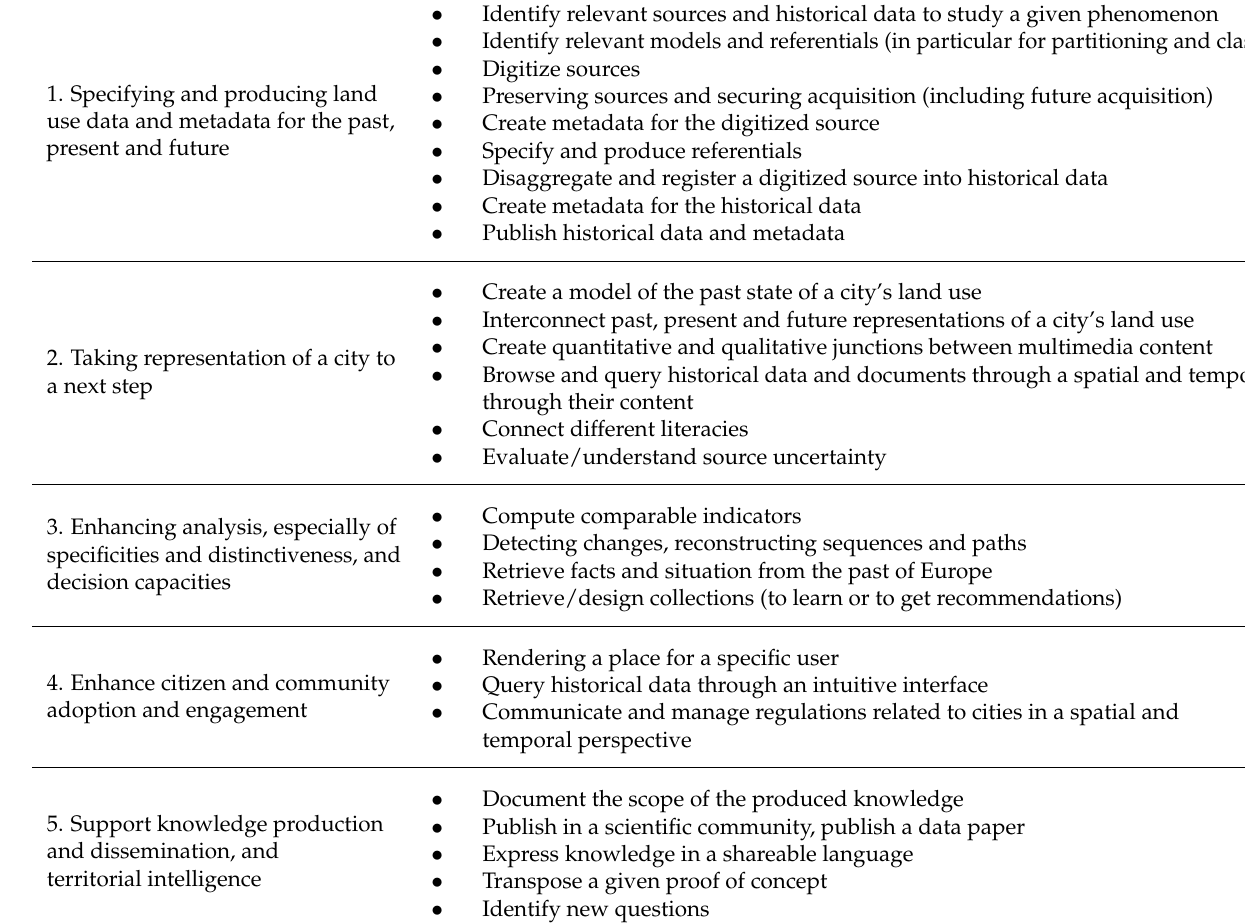
Table 1. The LandUseWheel: functional requirements for culture-aware land use information infrastructures grounded in historical